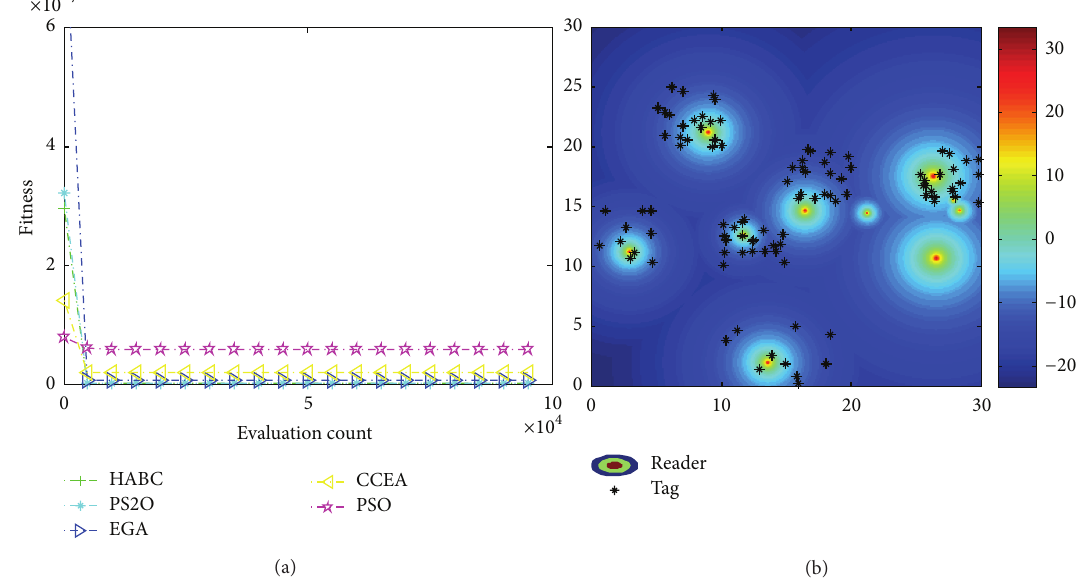
Figure 11: Results only consider economic efficiency. (a) Convergence process; (b) reader location and received power distribution.